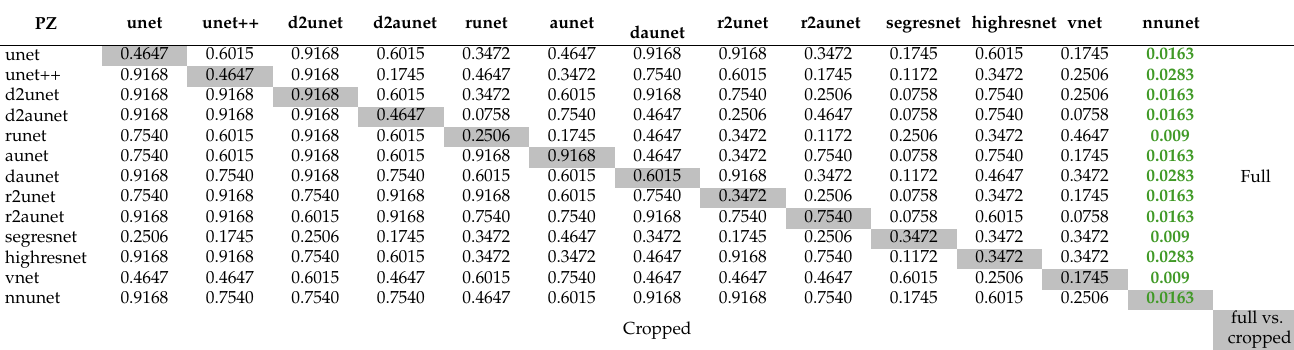
Table A3. p -values using Kruskal–Wallis for the dice scores obtained in the cross-validation of the peripheral segmentation task. On the top area we compare the performance of the different architectures on the full data, and on the bottom on the cropped data. On the diagonal we present the comparison of the same architecture on both data types. Significant values ( p < 0.05) are highlighted in